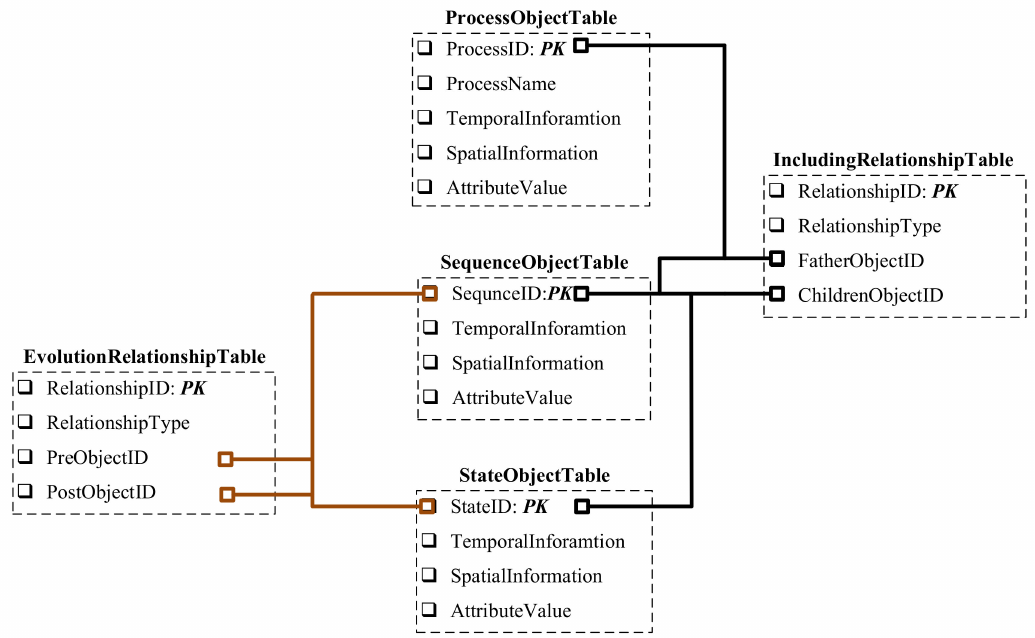
Figure 10. A schema of the object relational database: The black line links the process objects, and the orange line links the evolution